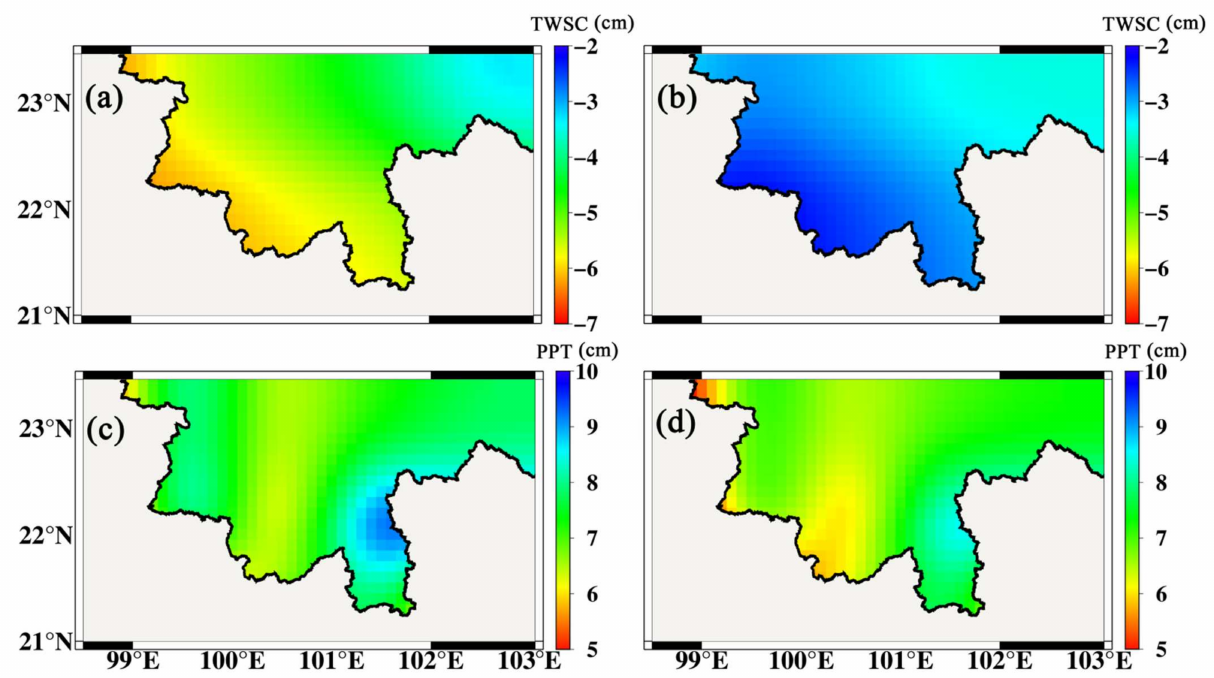
Figure 14. The spatial distribution of GRACE TWSC and PPT for the differences between high- and low-fire years in region S. The left and right column show the monthly average of GRACE TWSC ( a , b ) and PPT ( c , d ) in high- and low-fire years,